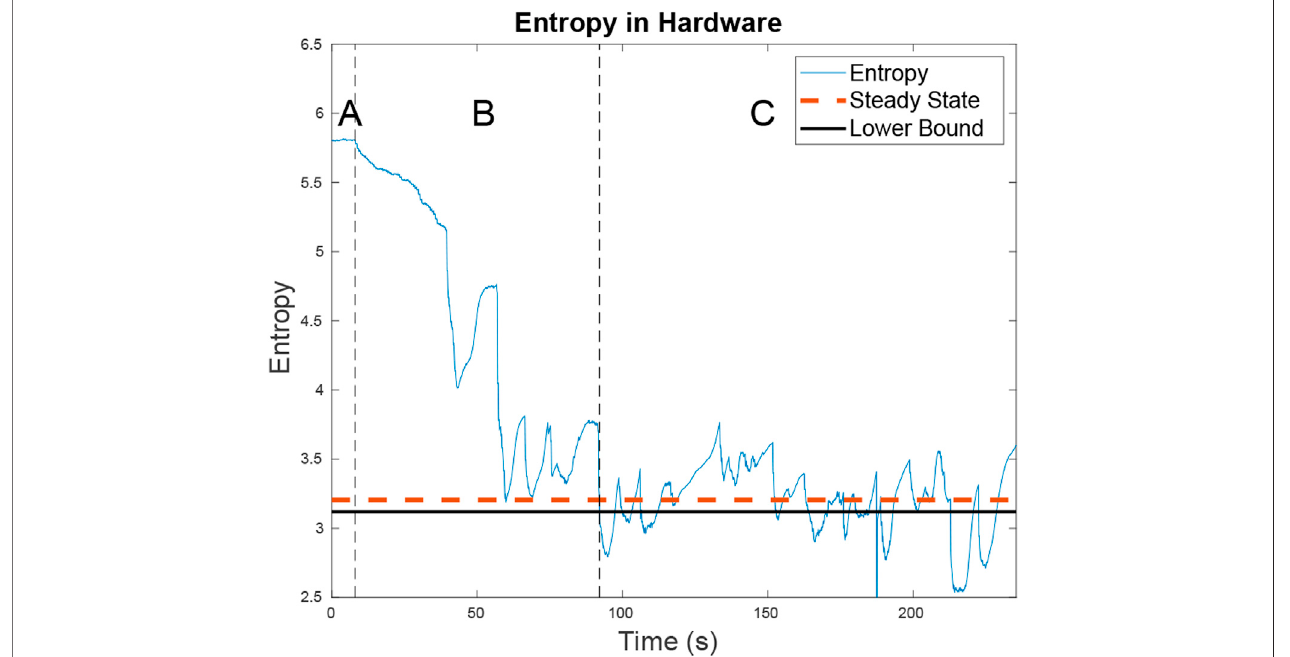
FIGURE 14 | The entropy for the two targets as well as the steady state entropy for the hardware test is shown. In region A , the UAV is searching for targets. In region B , the UAV has located the fi rst target and is looking for the second. In region C , the UAV is trying to minimize entropy across both targets. The steady state entropy of around 3.206 which is just slightly higher than the lower bound of 3.119 U of entropy. This is expected as on a small map the ERHC planner will work comparatively to the ideal planner.